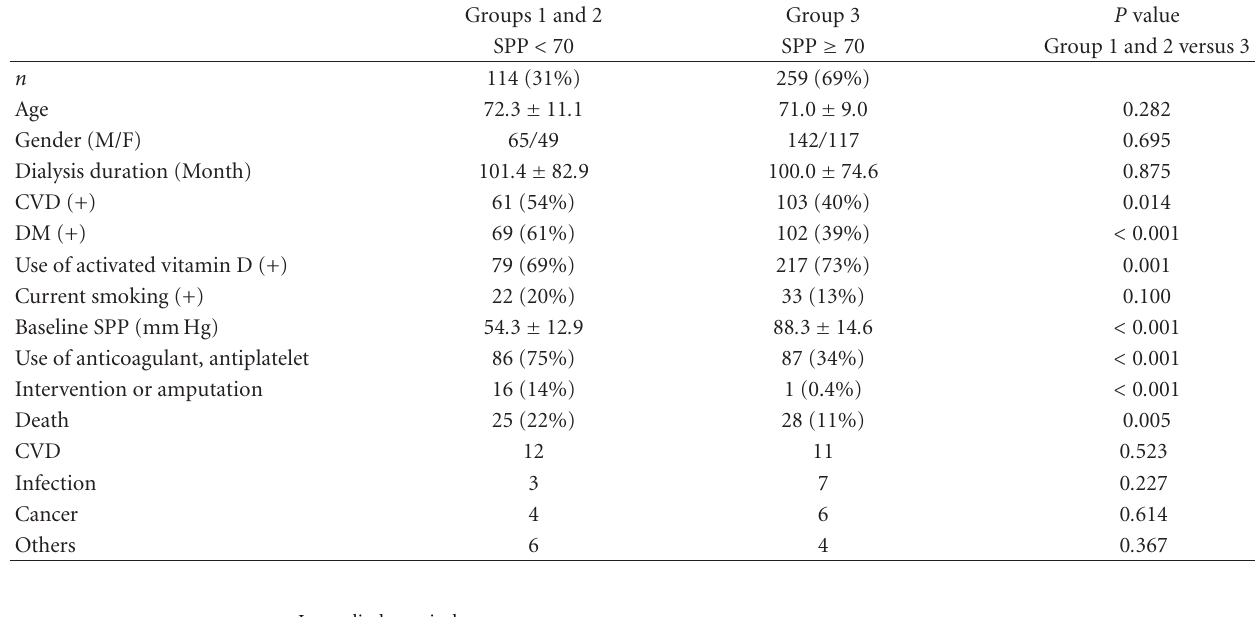
Table 2: Recategorization of patient characteristics with a skin perfusion pressure (SPP) cuto ff value of 70 mmHg. We recategorized patients into two SPP groups: Groups 1 and 2: < 70 and Group 3: ≥ 70. P value refers to Student’s t -test or chi-square analysis.